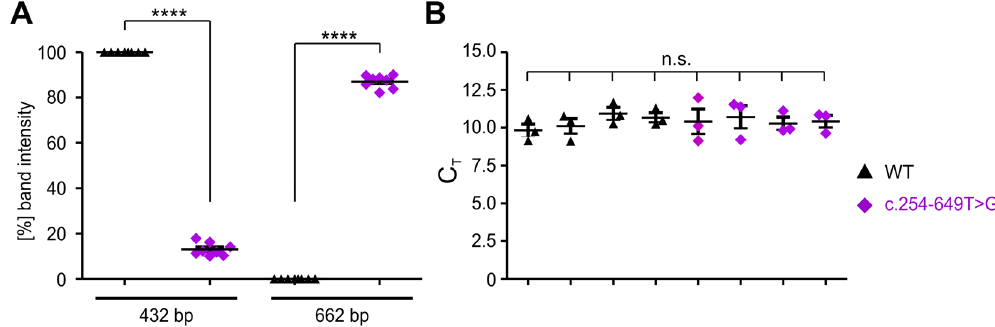
Figure 4. Quantification of the RT-PCR results shown in Fig. 3C. ( A ) Quantification of eight RT-PCR experiments resulting from four independent transfection experiments for both WT and c.254–649T > G mutant for the 432 bp and 662 bp bands. The single values are given as percentages of the total band intensities ± standard error of the mean (SEM). ( B ) Quantification of the single WT and the c.254–649T > G cDNAs used for the calculation of band intensities displayed in ( A ). Shown are the mean C T values (n = 3) ± SEM for aminolevulinic acid synthase (ALAS) as housekeeper gene. The single values are summarized in Table 1. For statistical analysis, one-way ANOVA followed by Tukeys test was used. * p < 0.05; ** p < 0.01; *** p < 0.001; **** p < 0.0001.